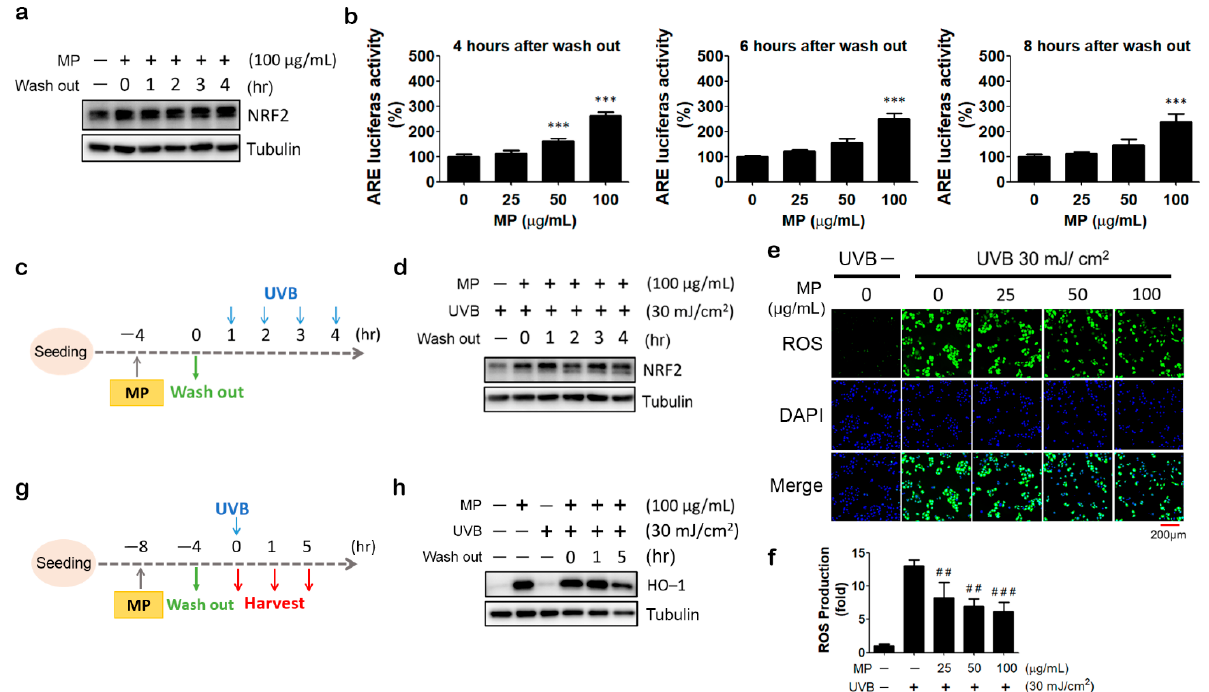
Figure 3. MP fraction induced prolonged activation of NRF2 and reversed UVB’s effects on NRF2, HO − 1, and ROS level in HaCaT cells. ( a ) Cells were treated with MP fraction for 4 h and washed out for 0 to 4 h, then cells were harvested for immunoblot. ( b ) Cells were incubated with MP fraction for 4 h and washed out for 4, 6, and 8 h for reporter assay. ( c , d ) Cells were treated with MP fraction for 4 h and washed out for 0 to 4 h before UVB irradiation, then cells were harvested for immunoblot. ( e , f ) Cells were treated with MP fraction for 4 h and washed out for 4 h prior to UVB irradiation for intracellular ROS detection assay. ( g , h ) Cells were pre-treated with MP fraction for 4 h and washed out for 4 h before UVB irradiation. One to five hours after UVB exposure, cells were harvested for immunoblot. Data are presented as mean ± SD from three independent experiments. The statistical significance was defined as *** p < 0.001 compared with solvent control cells; ## p < 0.01, ### p < 0.001 compared with UVB-irradiated cells.